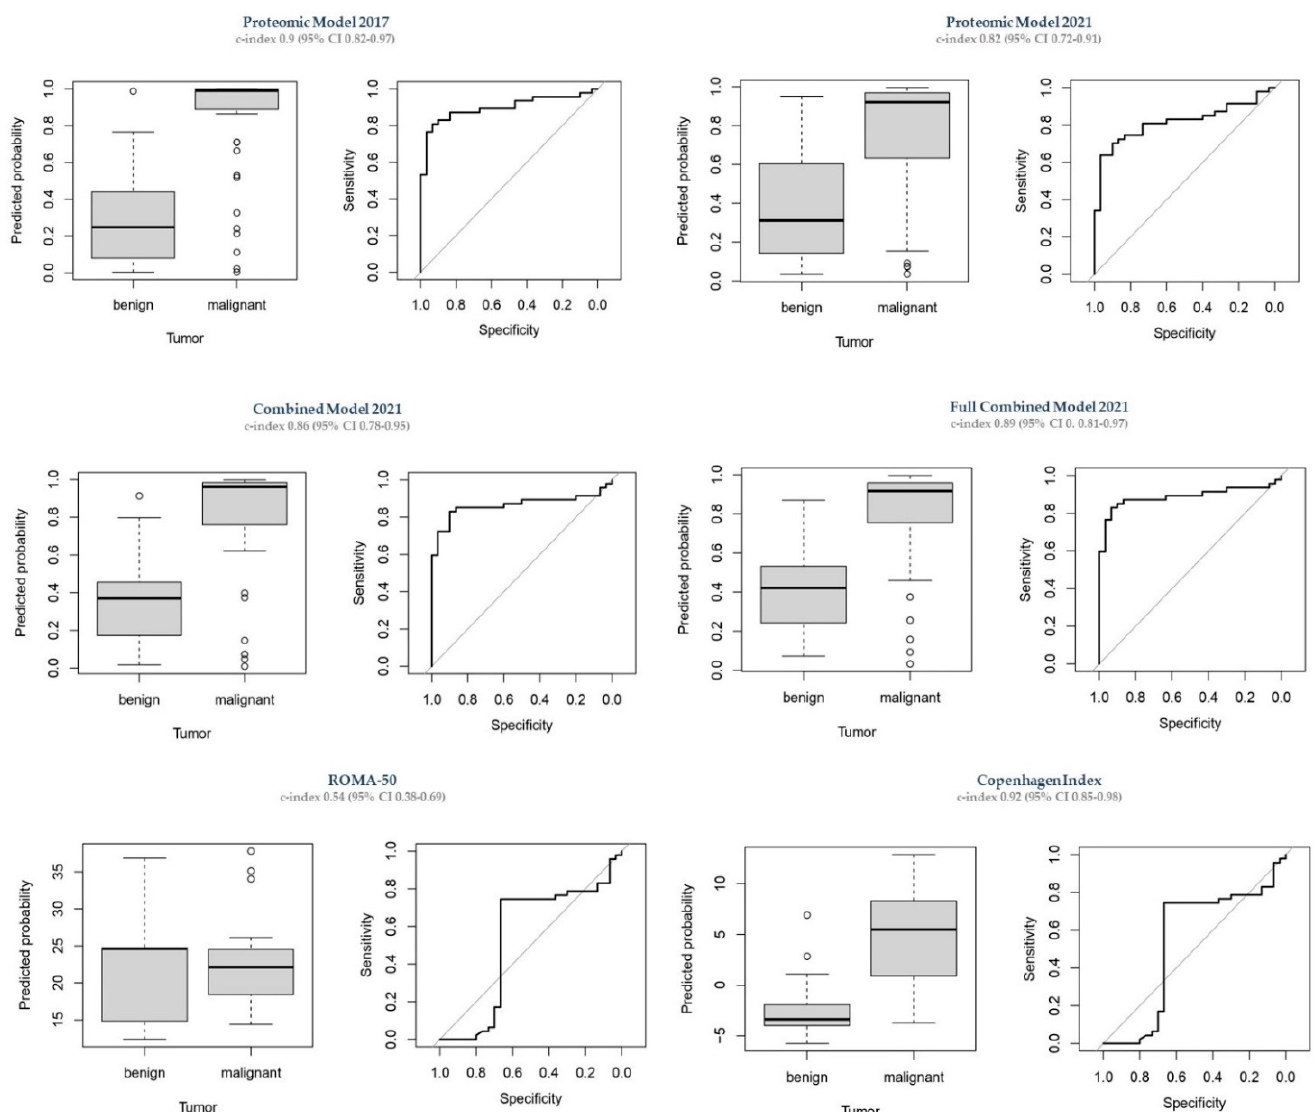
Figure 2. Diagnostic performance of all models in the validation cohort.